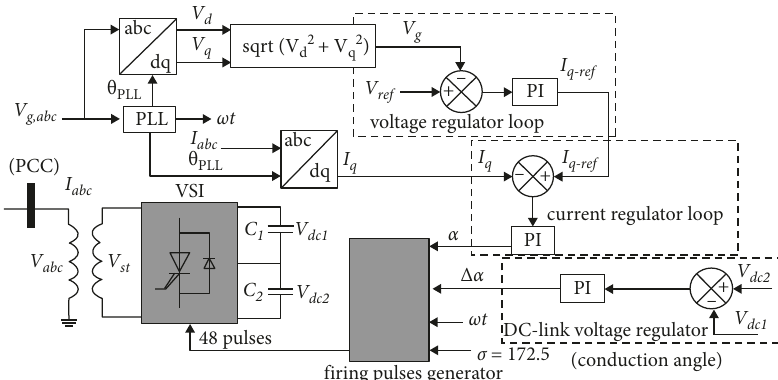
Figure 5: STATCOM control scheme